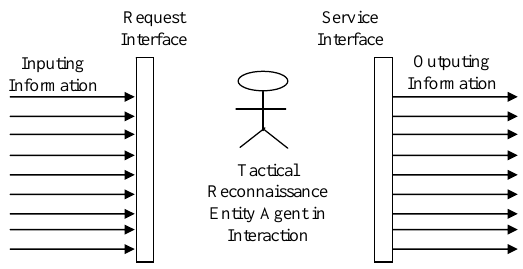
Fig. 5. A tactical reconnaissance entity agent and information interaction.